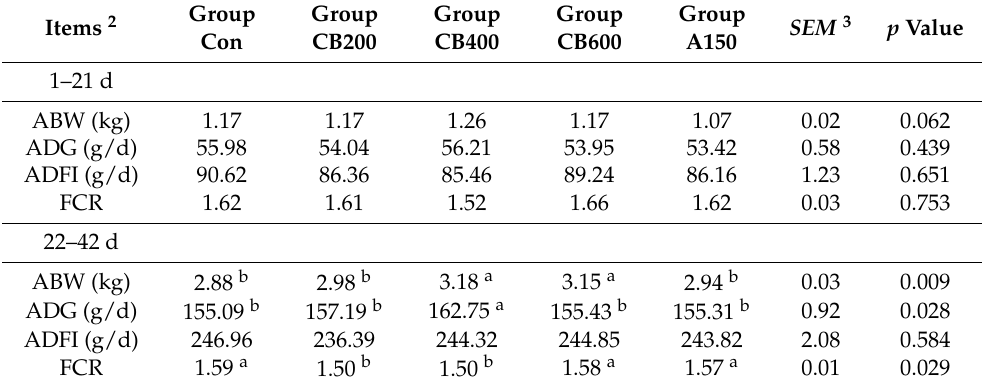
Table 2. Effects of Clostridium butyricum and aureomycin on growth performance of Pekin ducks 1